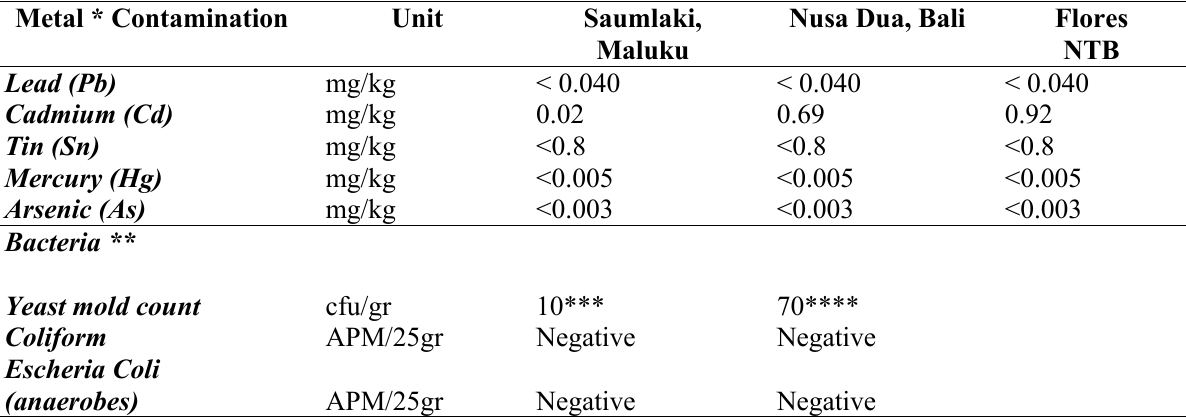
Table 1 . Analysis of seaweed metal and bacterial contamination from Saumlaki, Nusa Dua and Flores Metal * Contamination